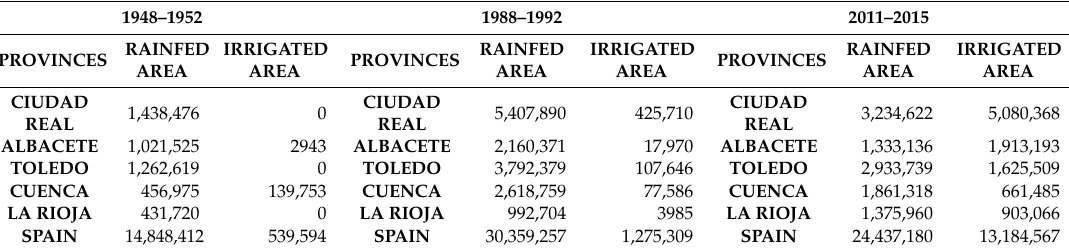
Table 1. Average rainfed and irrigated vineyard areas of Spain (in Ha).